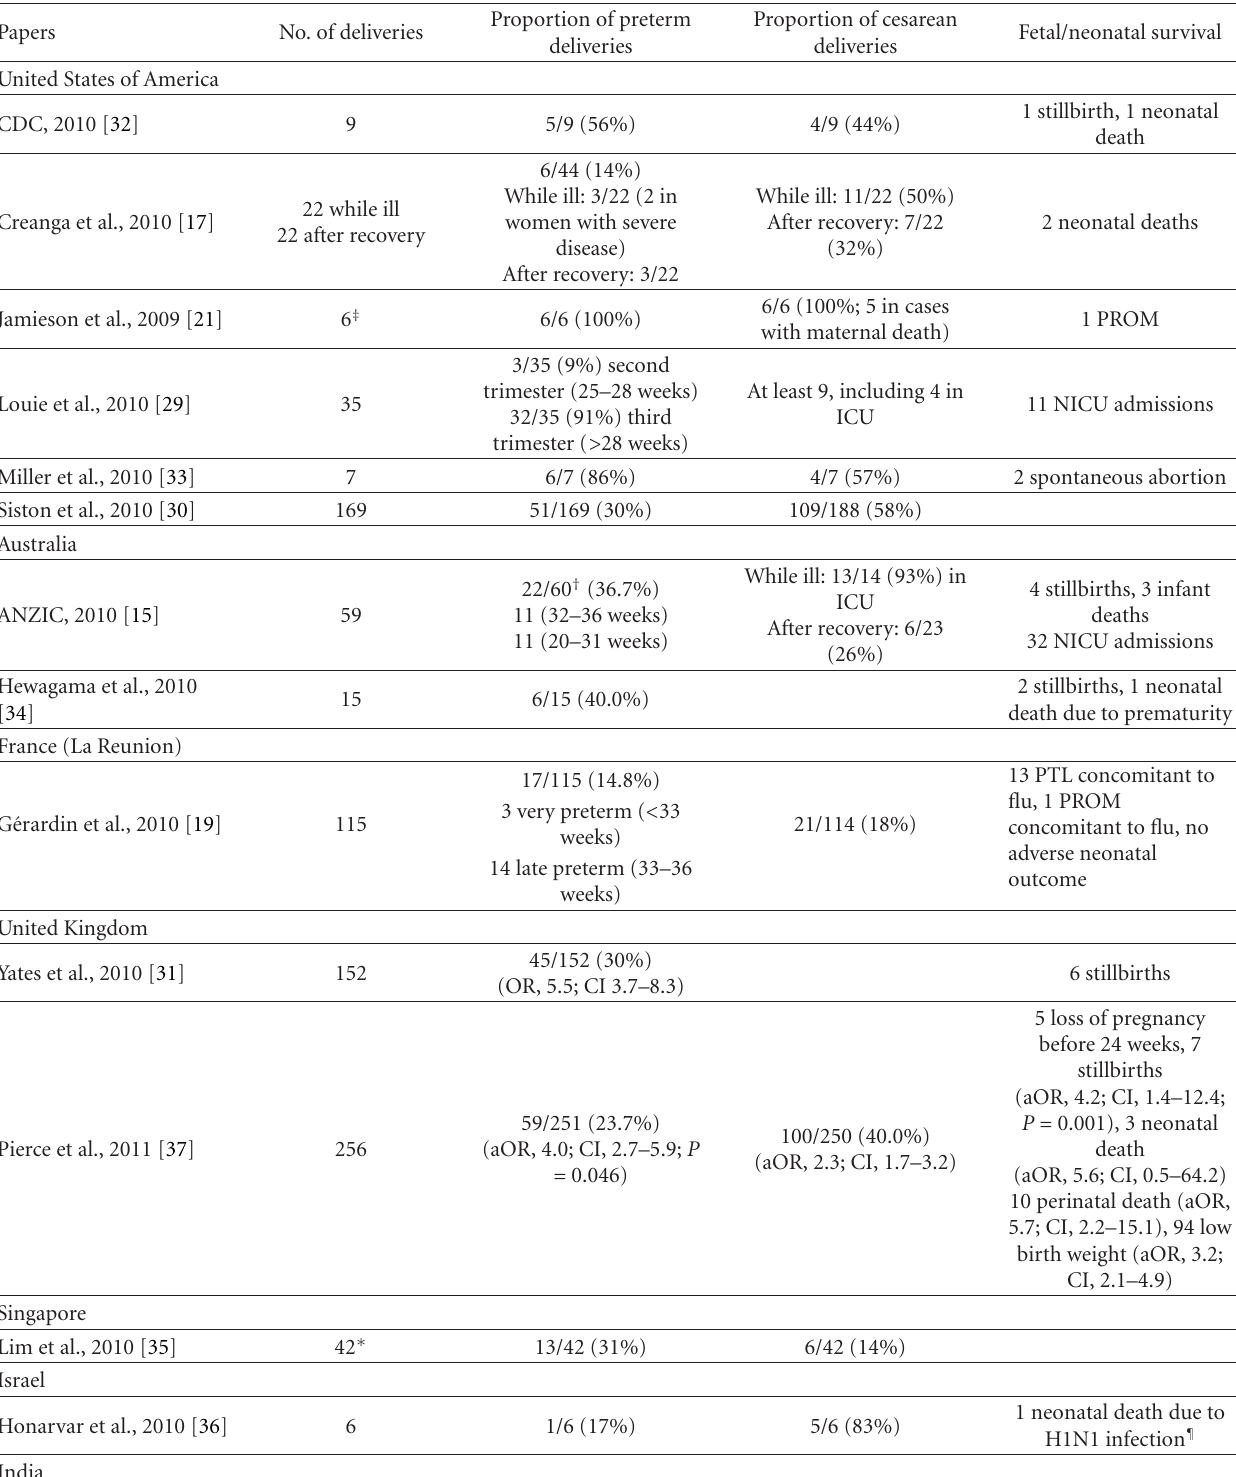
Table 2: Number of deliveries, gestational age, mode of delivery, and neonatal outcome in pregnancies a ff ected by 2009 H1N1 influenza.